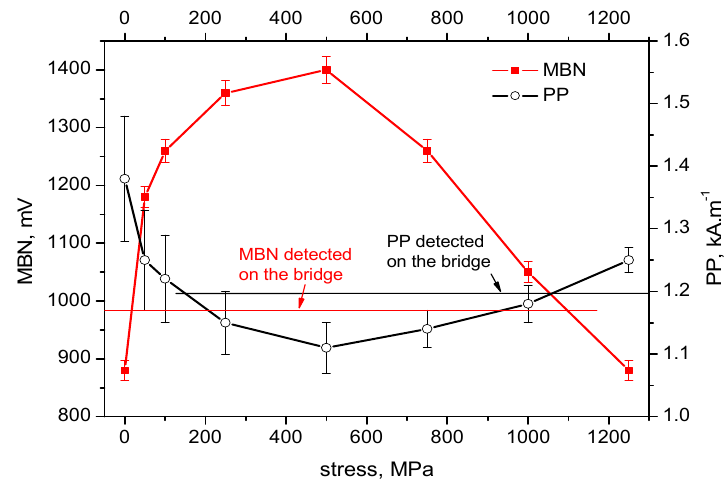
Figure 7. MBN and PP as a function of stress—wire n.4.